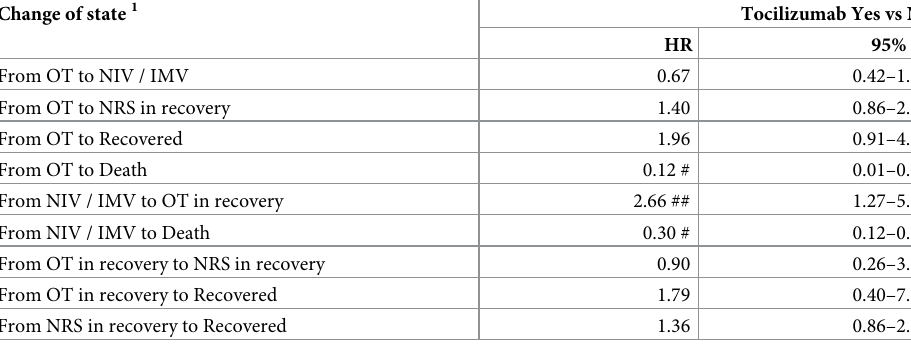
Table 3. Adjusted effect of administration of tocilizumab on change of state